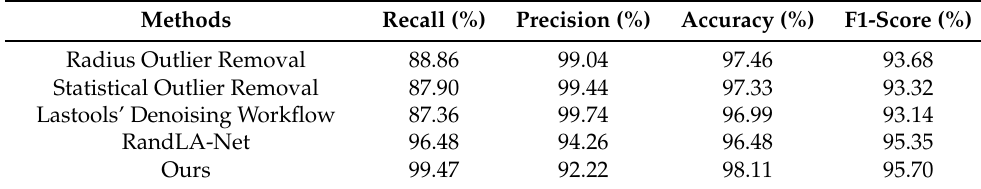
Table 4. Performance evaluation of the compared approaches and ours in the mountain area.